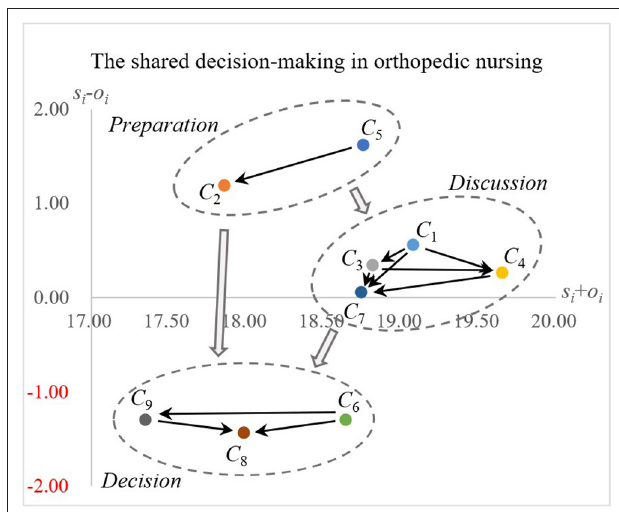
FIGURE 1 | The influential network-relation map of shared decision-making for orthopedic